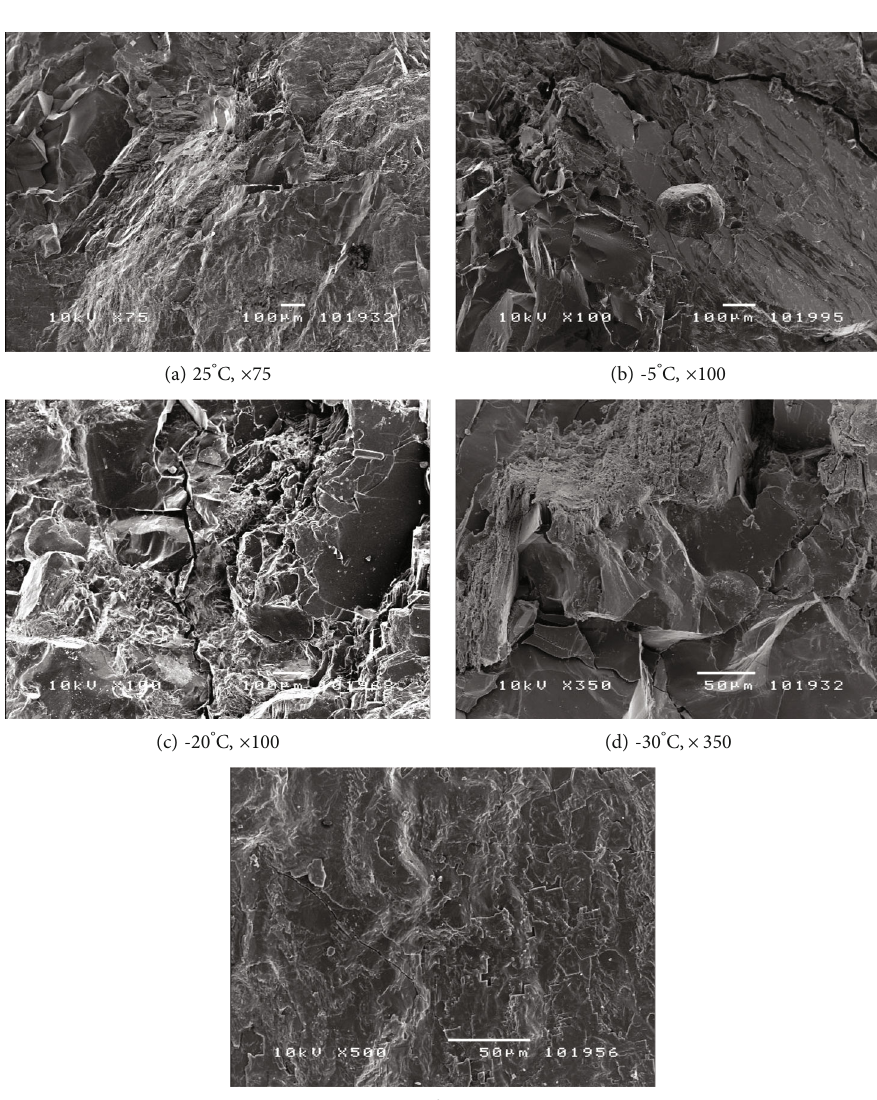
Figure 21: Fracture morphology of granite in di ff erent